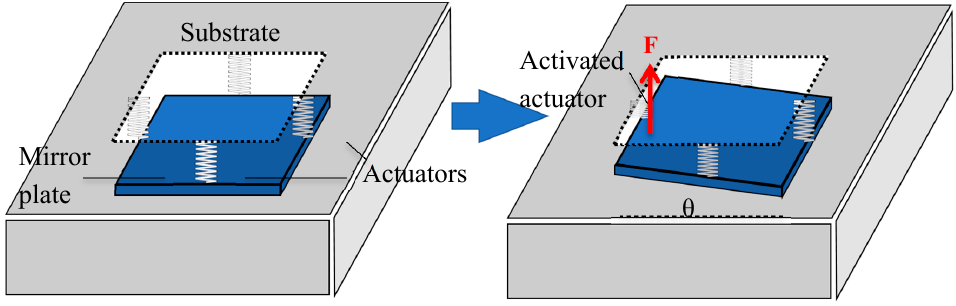
Figure 3. The mass-spring model of the MEMS mirror. Only the bimorph actuator on the left is activated.